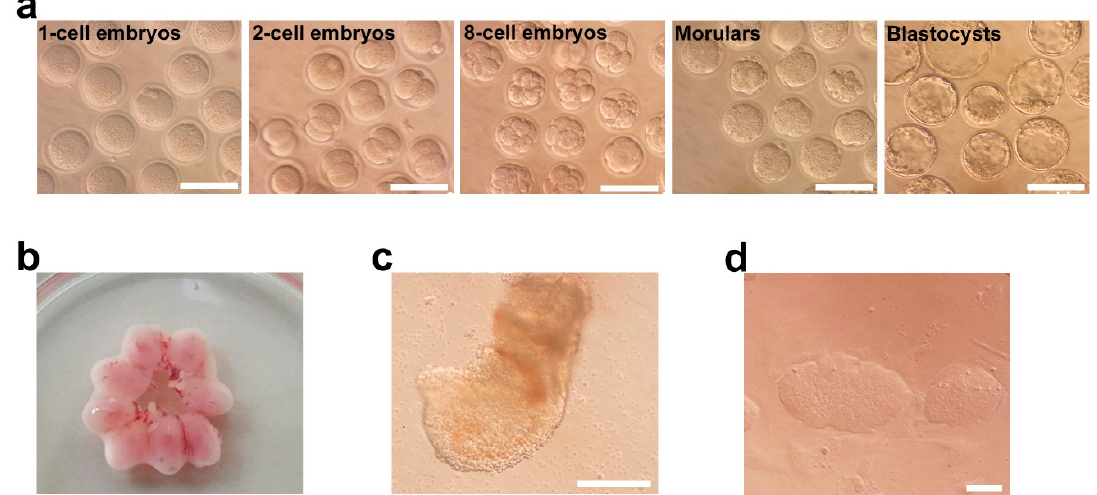
Figure 1. Pre- and post-implantation development of parthenogenetic embryos and generation of parthenogenetic epiblast stem cells (pEpiSCs). ( a ) Representative images of pre-implantation parthenogenetic embryos. Parthenogenetic activation resulted in two-cell embryos (79%, 27 / 34) and blastocysts (53%, 18 / 34). Scale bars represent 100 µ m. ( b ) Isolated uterus containing conceptus at 7.5 dpc. ( c ) Representative image of 7.5 dpc parthenogenetic post-implantation embryo containing cup-shaped epiblasts. Scale bar represents 100 µ m. ( d ) pEpiSC colonies at passage 20. Scale bar represents 50 µm.